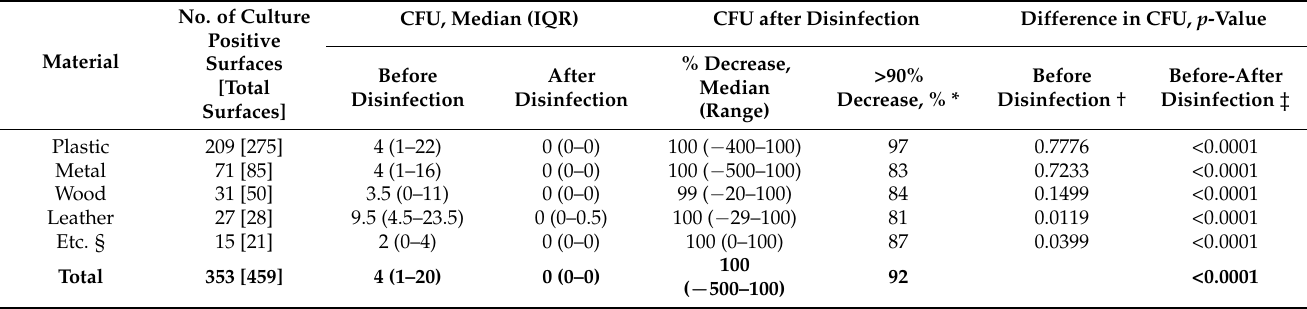
Table 3. CFU values of gram-positive bacteria from seven types of materials before and after disinfection with plasma-treated hydrogen peroxide mist